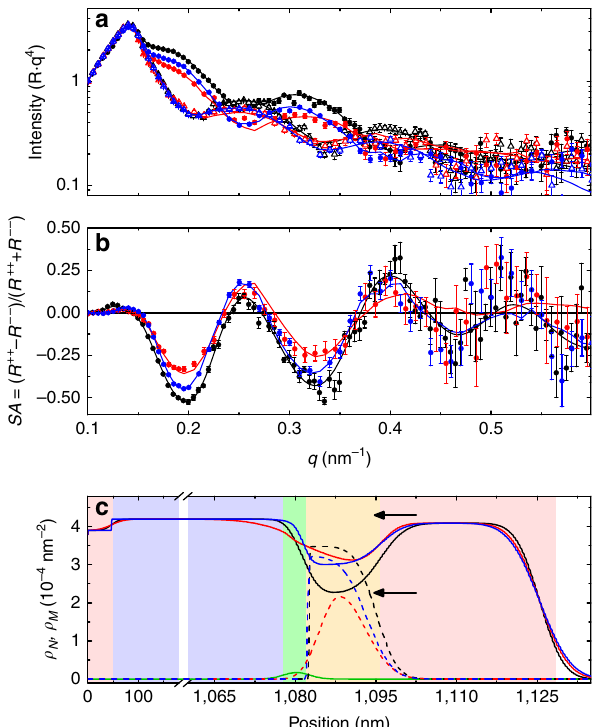
Figure 1 | PNR results of E þ T-conditioned sample. ( a ) Fitted PNR data, with R þ þ ( R (cid:2) (cid:2) ) identified by solid circles (open triangles), scaled by q 4 and ( b ) spin asymmetry for the sample as-grown and after E þ T conditioning. ( c ) Depth-dependent real and imaginary nuclear SLD ( r N and r imag ), and magnetic SLD ( r M ) extracted from the PNR. In all panels black, red and blue lines identify the as-grown, þ 40V conditioned, and þ / (cid:2) 40V conditioned samples, respectively. In c the solid and dashed lines identify r N and r M , respectively, and the green line identifies r imag . Background colours in c represent (red) Pd, (purple) AlO x , (green) GdO x and (yellow) Co, respectively. In a and b the experimental data are shown as symbols, and the lines are fits corresponding to the depth profile shown in c . Error bars in a and b correspond to ± 1s.d.; error bars for c are shown in Supplementary Fig. 2. Arrows in a and b identify the bulk r N for Co (2.25 (cid:3) 10 (cid:2) 4 nm (cid:2) 2 ) and CoO (4.29 (cid:3) 10 (cid:2) 4 nm (cid:2) 2